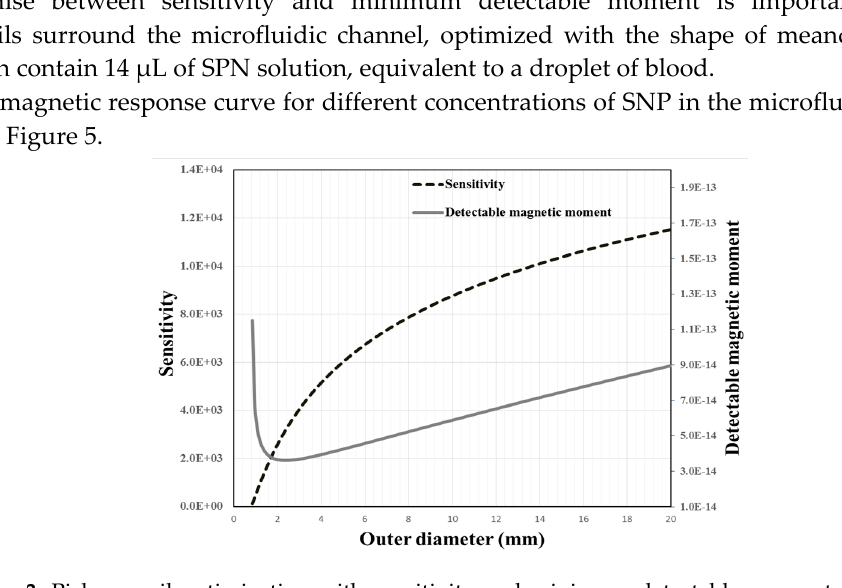
Figure 3. Pick-up coil optimization with sensitivity and minimum detectable moment versus coil outer radius. Internal radius fixed at 0.8 mm.